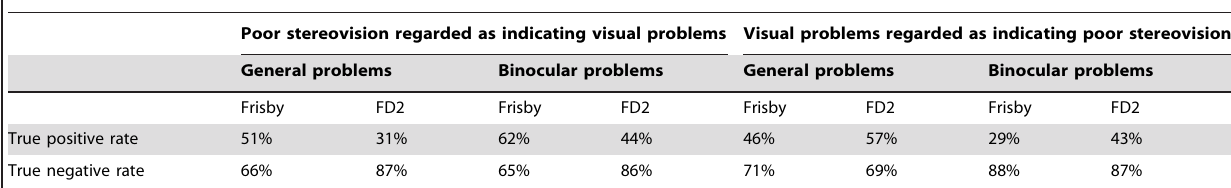
Table 7. Quantifying how reliably poor stereovision (threshold . 20arcsec) is associated with visual problems, either any visual problem or a specifically binocular